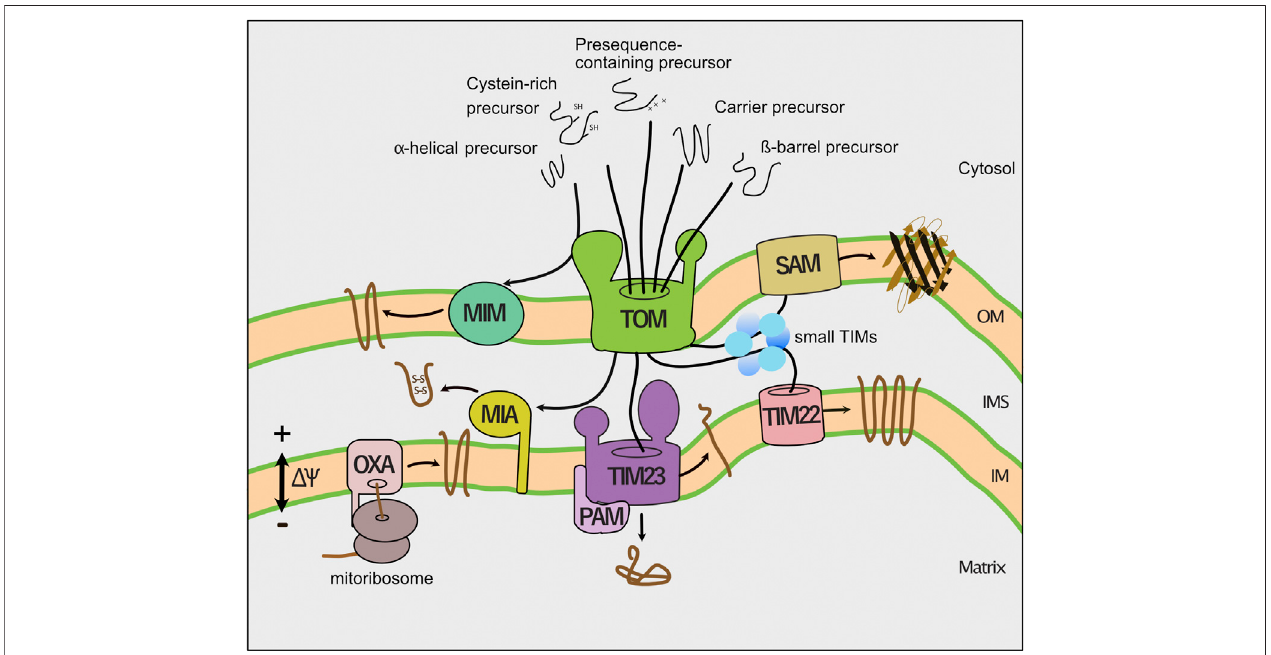
FIGURE 1 | Pathways of mitochondrial protein import. Dedicated protein translocases import precursor proteins into the mitochondrial subcompartments. First, the translocase of the outer membrane (TOM complex) transports precursor proteins across the outer membrane (OM). Second, the presequence translocase (TIM23 complex)sortprecursorswithacleavablepresequenceintotheinnermembrane(IM)andmatrix.Thepresequencetranslocase-associatedmotor(PAM)cooperateswith theTIM23complextocompleteproteintranslocationintothematrix.Third,thecarriertranslocase(TIM22)insertshydrophobicmultispanningproteinsintotheinner membrane that are guided by small TIM chaperones through the intermembrane space. The membrane potential ( Δ ψ ) drives protein transport into the inner membrane and matrix. Fourth, the mitochondrial intermembrane space import and assembly (MIA) machinery mediates oxidative folding of proteins with a cysteine-rich targeting signal.Fifth,thesortingandassemblymachinery(SAMcomplex)inserts β -barrelproteinsintotheoutermembrane(OM).Sixth,themitochondrialimport(MIM)machinery integrates proteins with a single or multiple α -helical membrane spans into the outer membrane. Finally, the oxidase assembly (OXA) translocase inserts mitochondria- encoded proteins into the inner